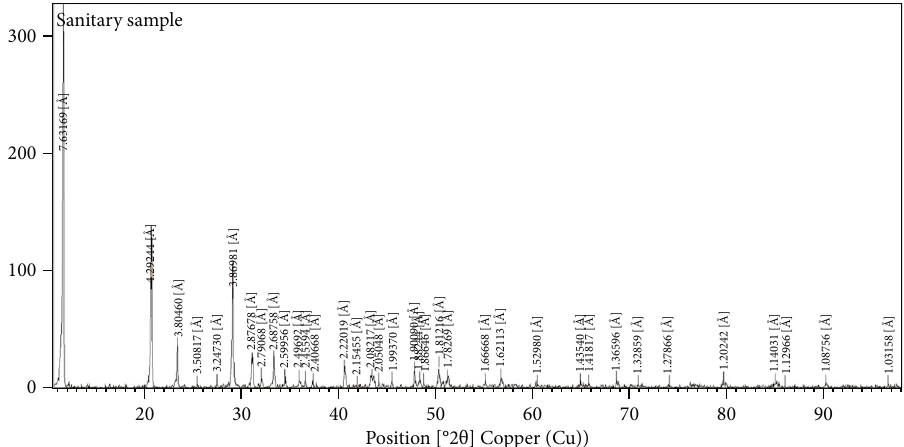
Figure 2: Mineralogical analysis of a sanitary ware sample.